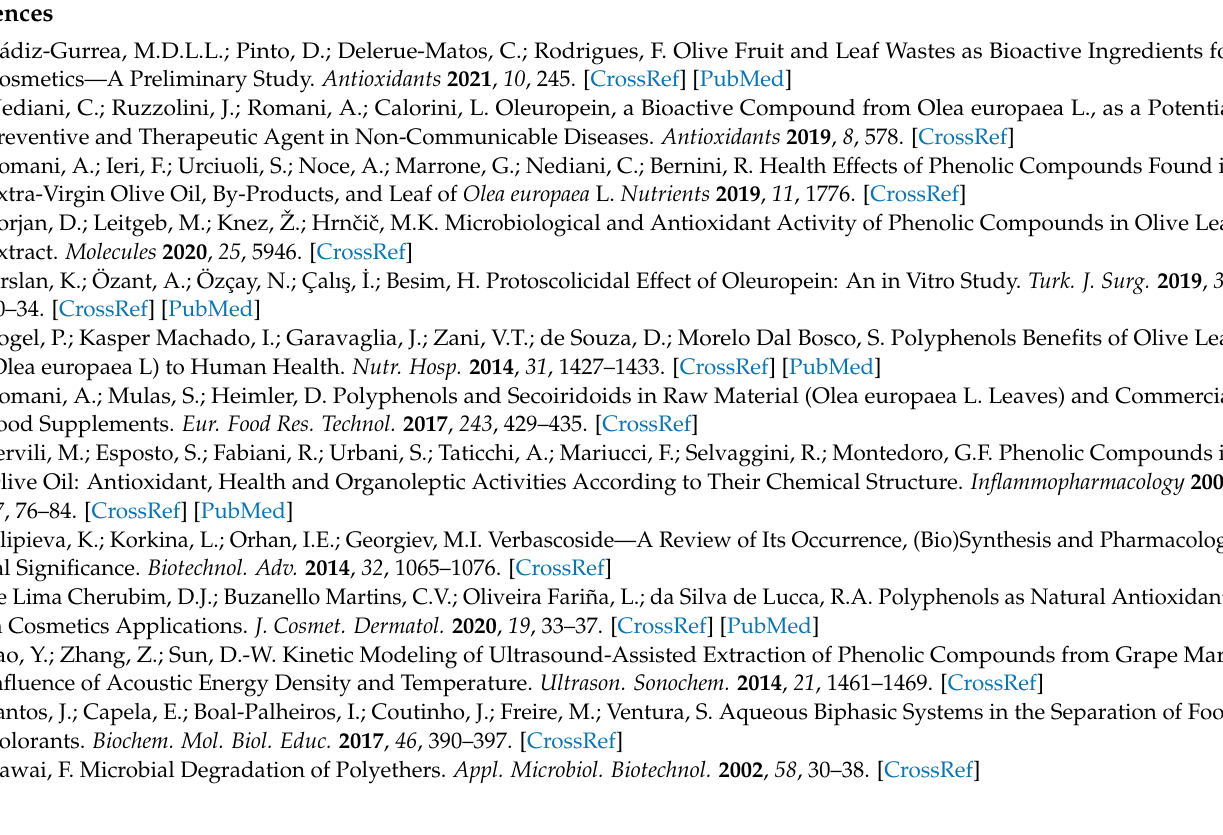
Supplementary Materials: Table S1: Physicochemical properties of the prepared solvents; Table S2: Relationship between the concentrations of the target compounds and the HM/SR; Table S3: Volume of the prepared extracts; Table S4: Relationship between yield (%) of the target compounds and the HM/SR; Table S5: Relationship between the extraction parameters and the extended